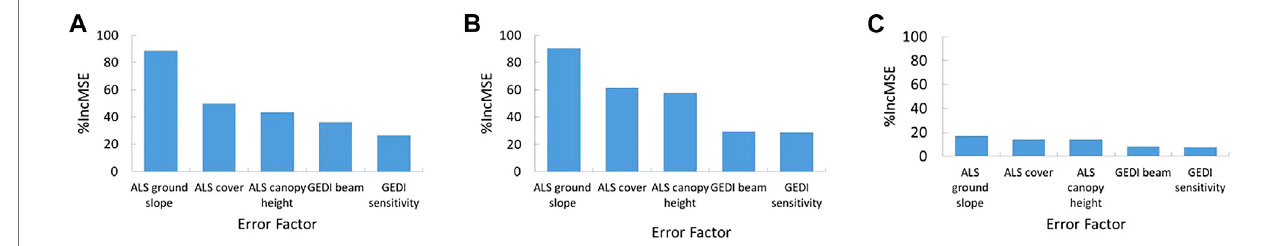
FIGURE 6 | Relative importance measured as percent increase in mean standard error (%IncMSE) of error factors in functional trait retrievals from GEDI. Variables with larger (%IncMSE) values are more important. (A) GEDI estimated canopy height (CH); (B) GEDI estimated plant area index (PAI), and (C) GEDI estimated foliage height diversity (FHD).